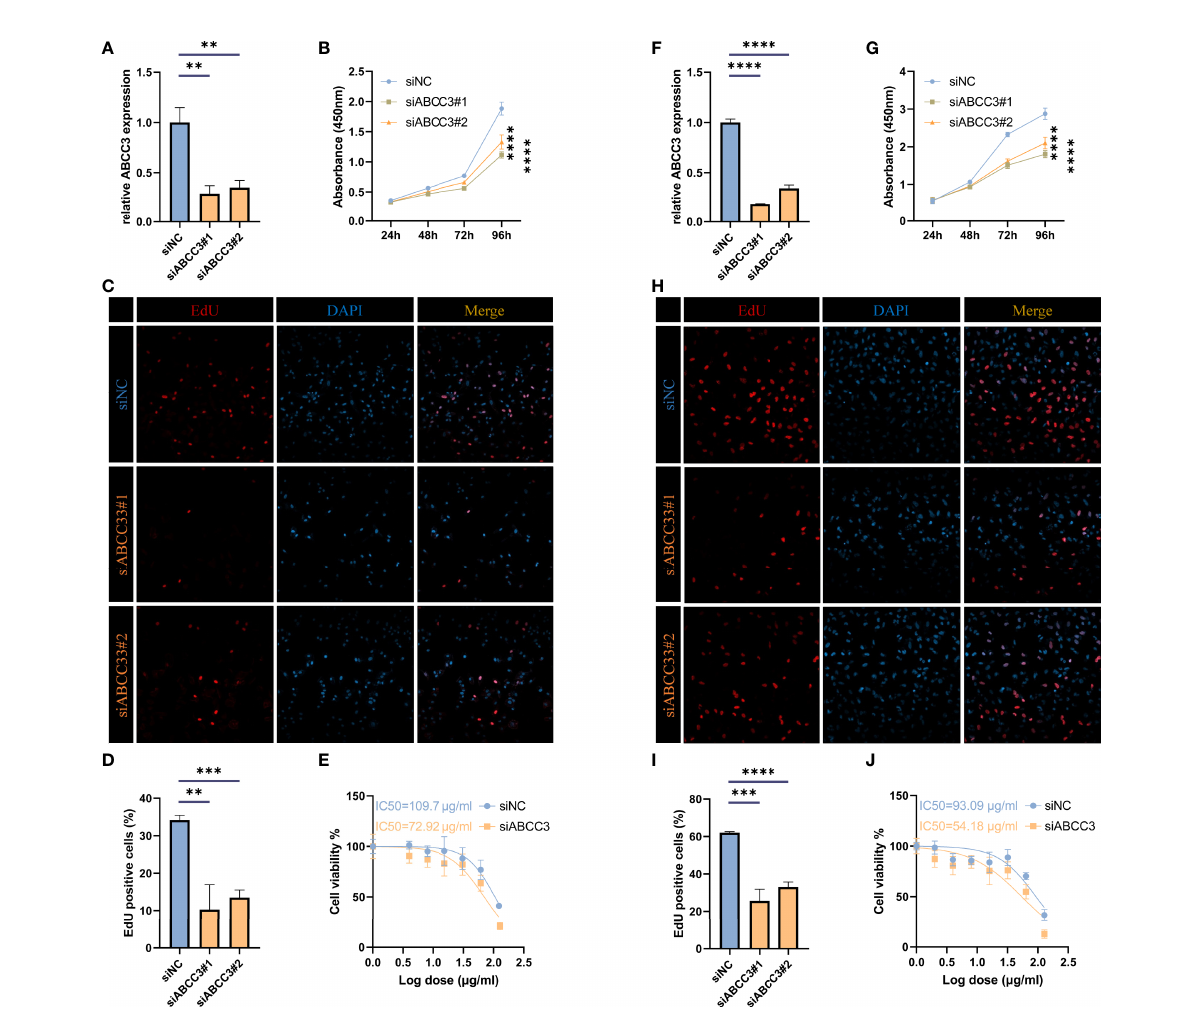
FIGURE 11 ABCC3 affects the proliferation of glioma cells. (A) TIMP1 knockdown ef fi ciency in U87 cells. (B) Growth curves of ABCC3-def fi cient and control U87 cells. (C, D) Proportion of EdU positive cells in ABCC3-def fi cient and control U87 cells. (E) IC50 analysis of resistance to TMZ in ABCC3- def fi cient and control U87 cells. (F) TIMP1 knockdown ef fi ciency in LN229 cells. (G) Growth curves of ABCC3-def fi cient and control LN229 cells. (H – I) Proportion of EdU positive cells in ABCC3-def fi cient and control LN229 cells. (J) IC50 analysis of resistance to TMZ in ABCC3-def fi cient and control LN229 cells. **, P < 0.01; ***, P < 0.001; ****, P <